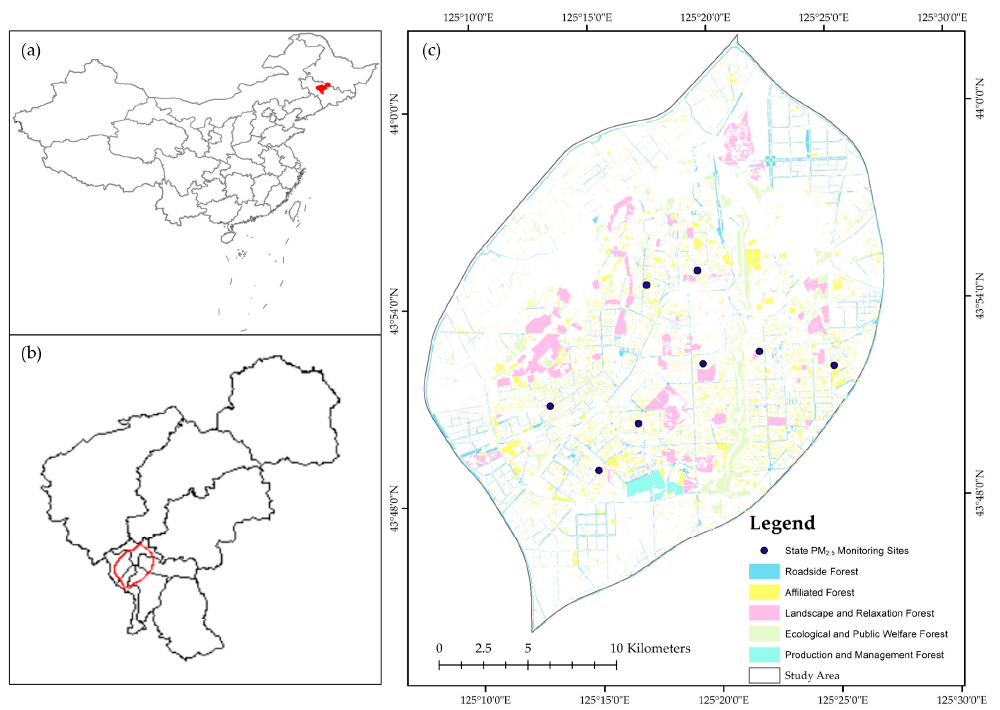
Figure 1. ( a ) The Administrative Map of China, with Changchun city displayed in red color. ( b ) The Administrative Map of Changchun city, with the red line indicated the built-up area. ( c ) Map of Changchun built-up area, different types of urban forest and the location of China State PM 2.5 Monitoring Sites.